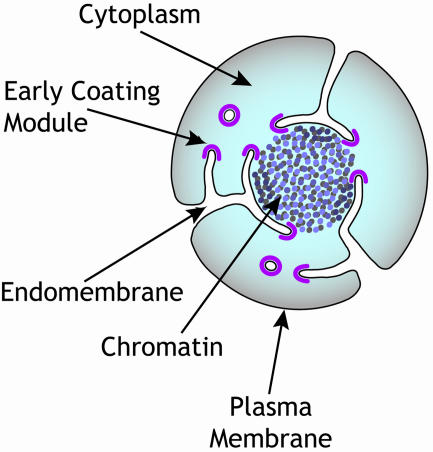
Early eukaryote?